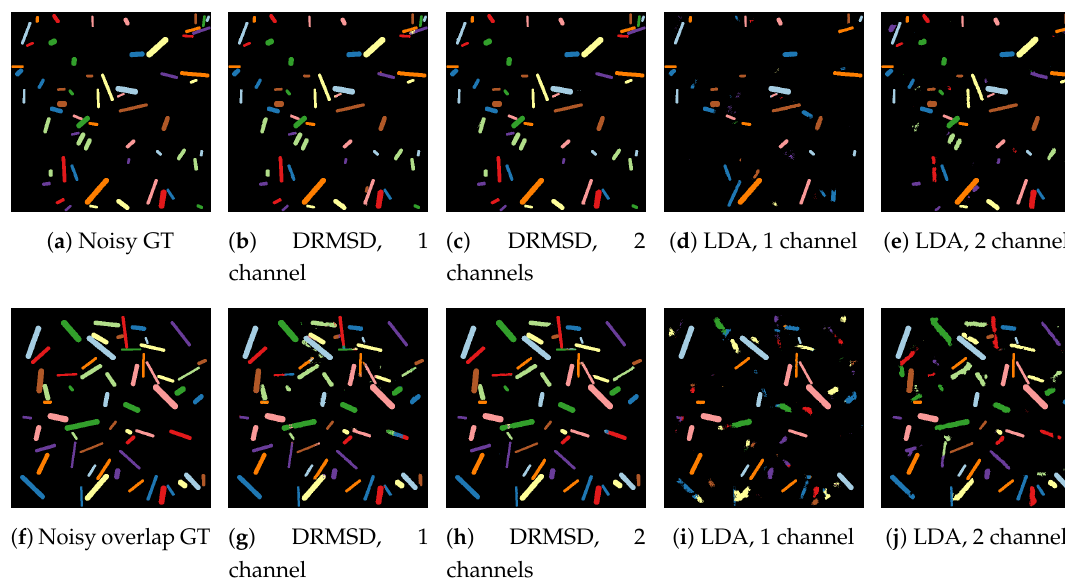
Figure 16. Visual results for LDA and DRMSD reduction schemes for reductions to 1 and 2 feature map channels on the noisy dataset ( a – e ) and the noisy overlapping dataset ( f – j